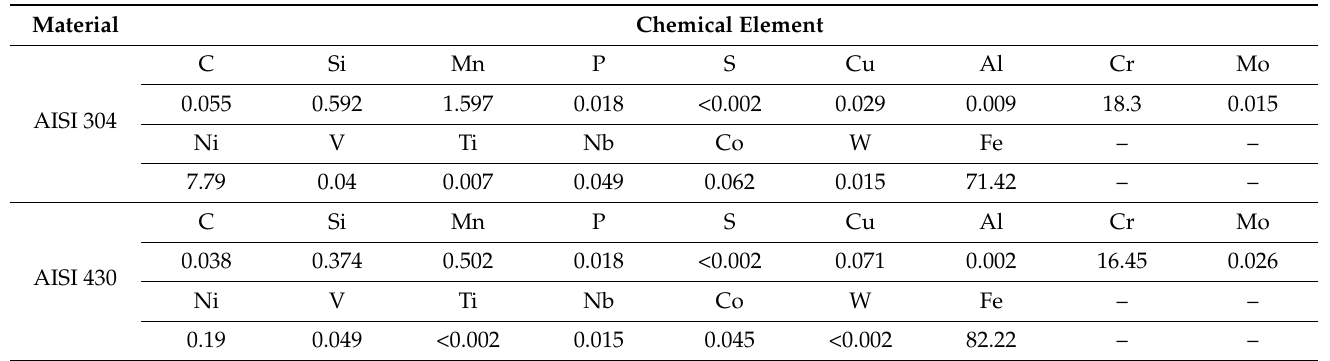
Table 2. Chemical composition of AISI 304 and 430 stainless steel (weight %).